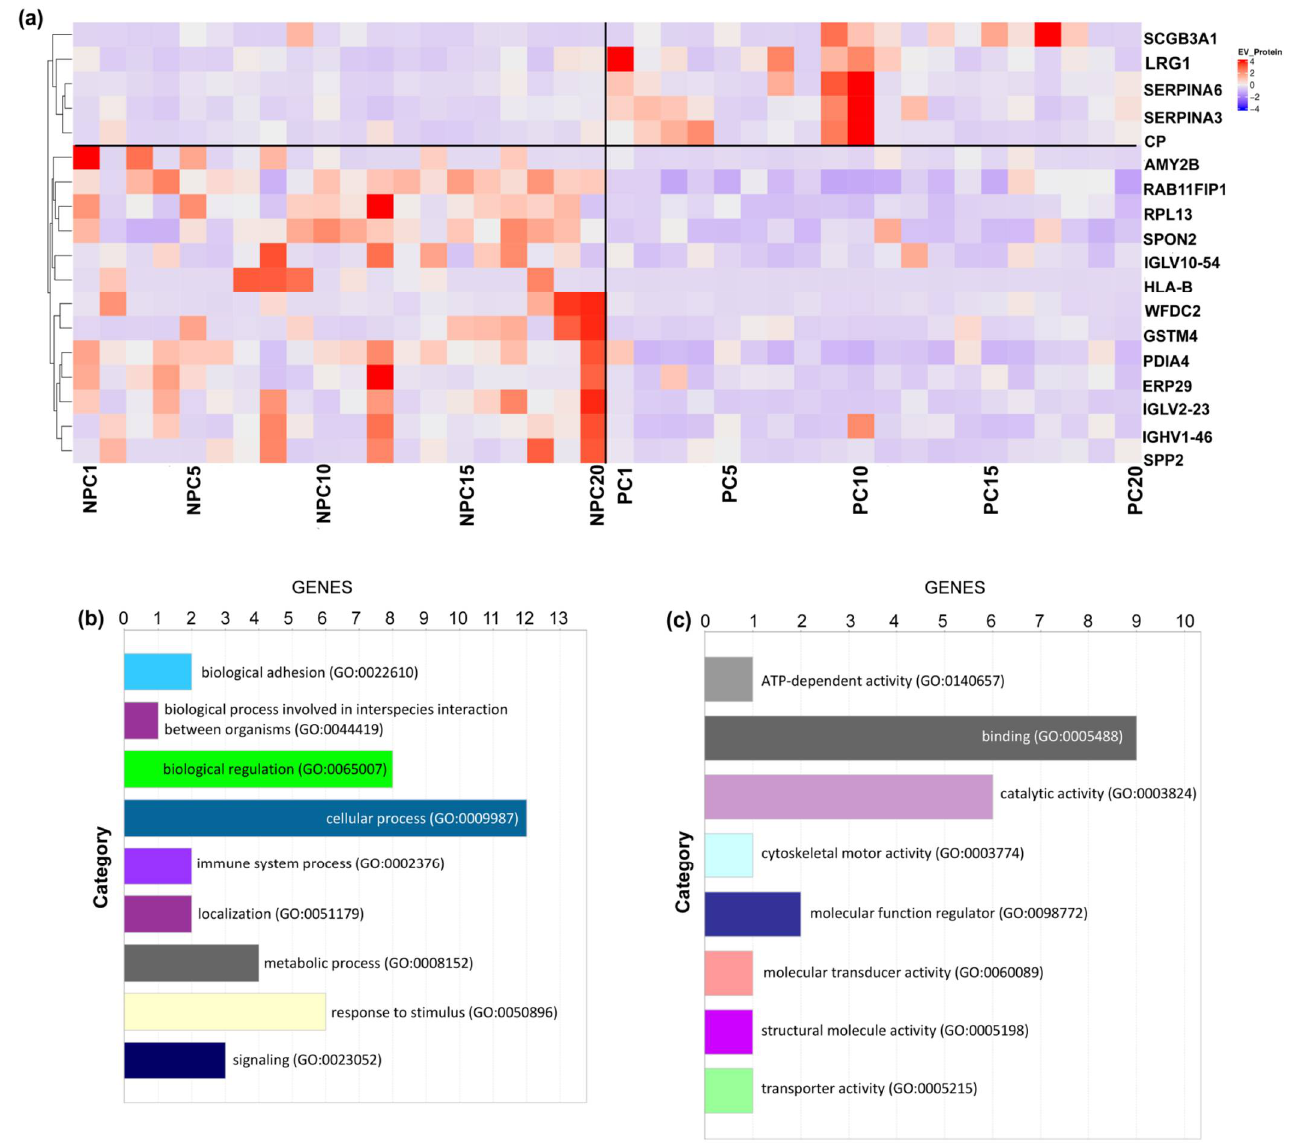
Figure 4. Unsupervised Clustering and Biological Annotation for Differentiated EV Proteins. ( a ) Unsupervised clustering of all included participants using the 18 EV proteins with a significant difference. Each column indicates one participant, and each row indicates one EV protein. The colors indicate either upregulated (red) or downregulated (purple). ( b ) Biological process analysis. ( c ) Enriched pathway analysis.